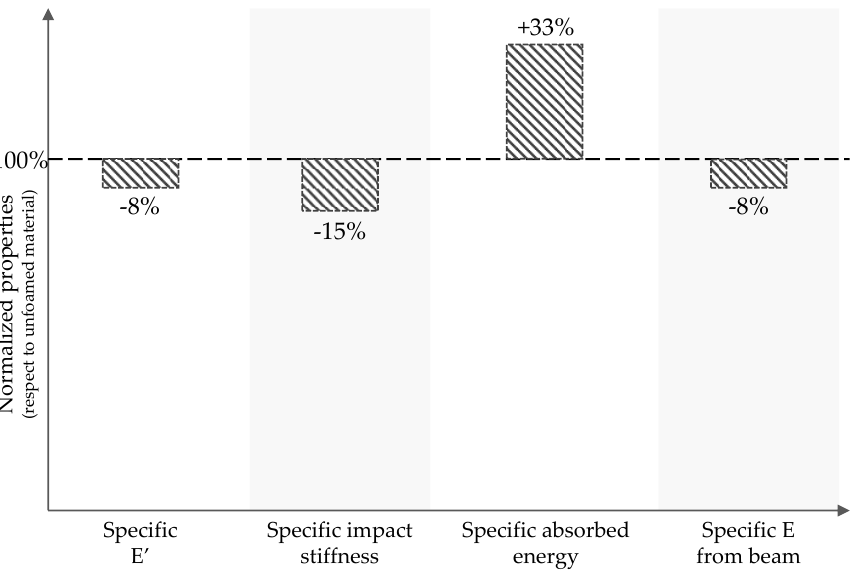
Figure 26. Normalized mechanical properties with respect to compact specimen.